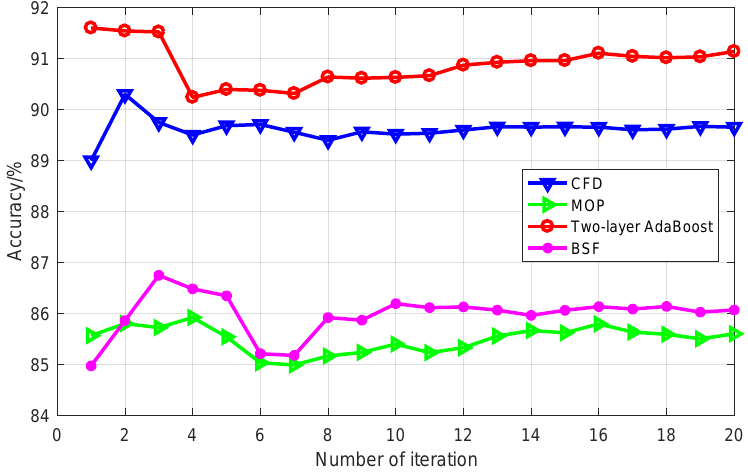
Figure 17. Comparison of different fusion algorithms.